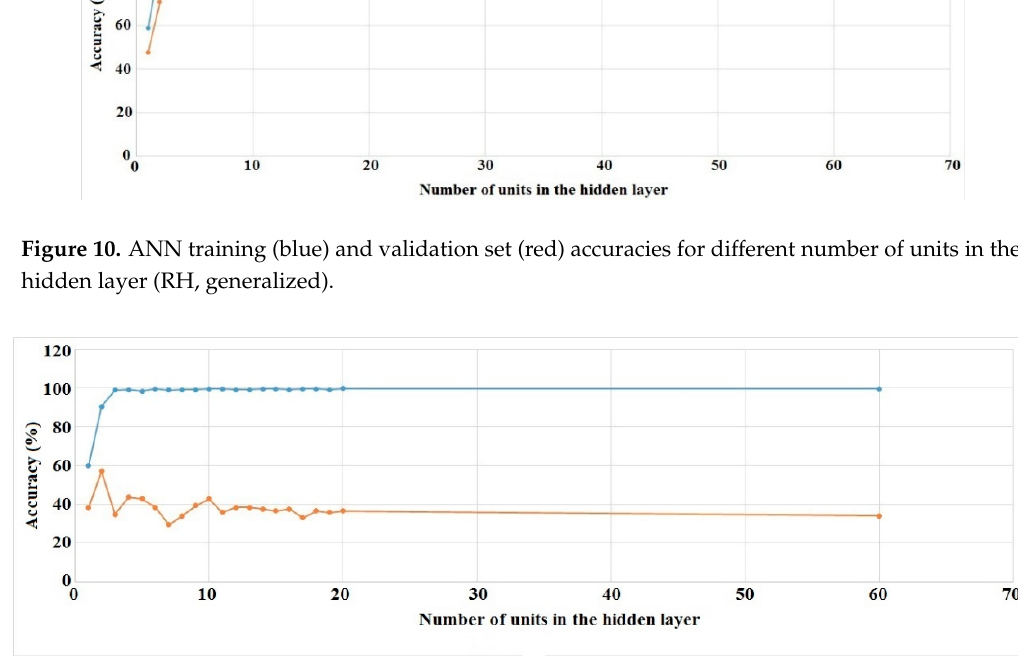
Table 2. Training and validation set accuracies for different datasets (generalized category).